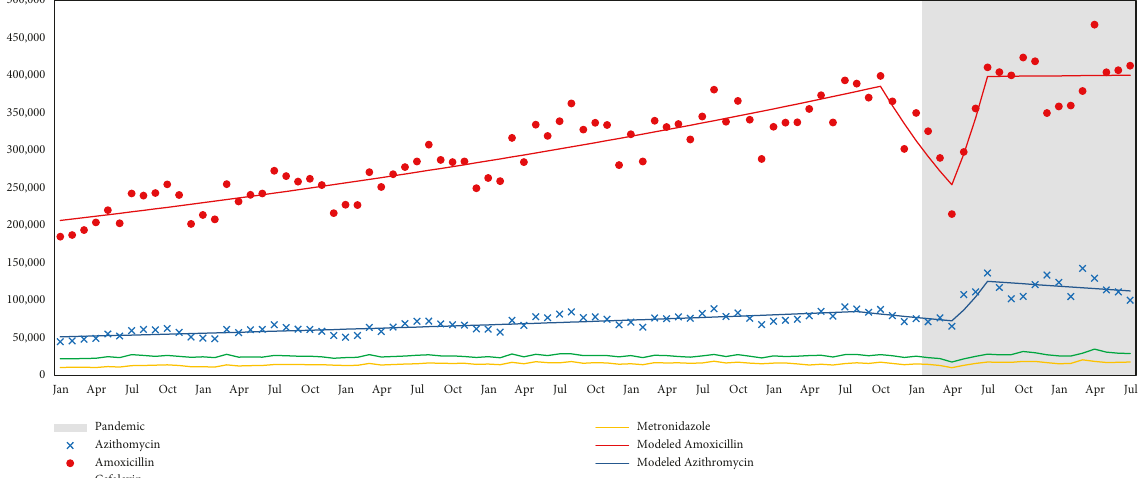
Figure 1: Evolution of azithromycin, amoxicillin, cephalexin, and metronidazole prescriptions between 2014 and 2021. Modeled regression analysis (Joinpoint regression) for amoxicillin and azithromycin and pandemic period (in